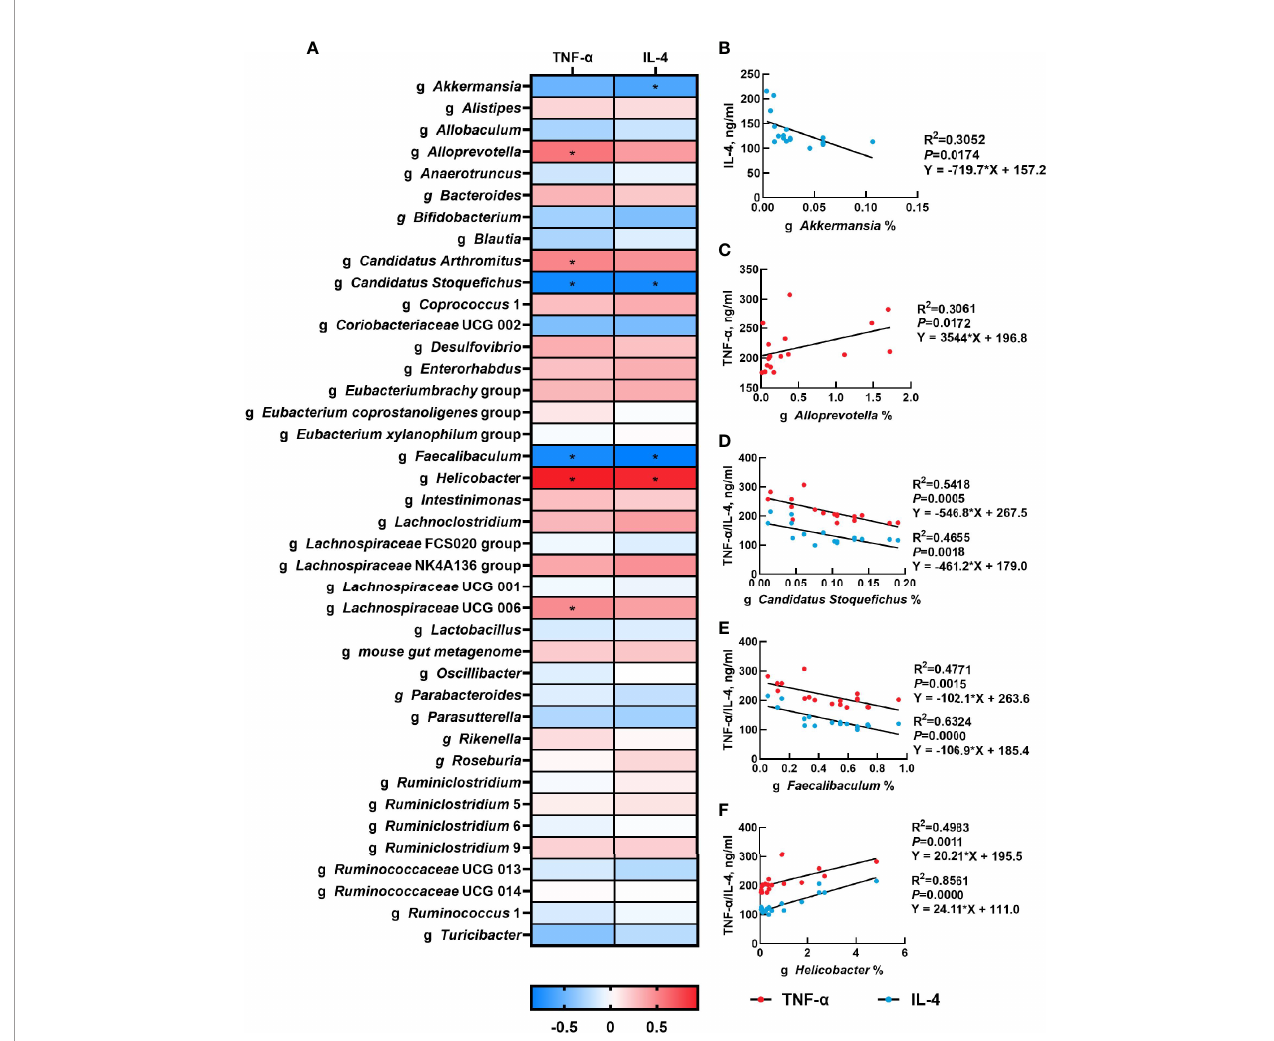
FIGURE 5 | Correlation analysis of gut microbiota and serum in fl ammatory cytokines. The correlation analysis between the abundance of top 40 microbial genera and serum in fl ammatory cytokines concentration (A) , and the linear correlation analysis between relative abundance of main microbial genera and in fl ammatory cytokines that signi fi cantly regulated by b -carotene (B-F) were analyzed by Spearman ’ s correlation analysis. CTL, a basal diet; CARL, a basal diet containing 30 mg/ kg b -carotene; CARH, a basal diet containing 90 mg/kg b -carotene. (* P <